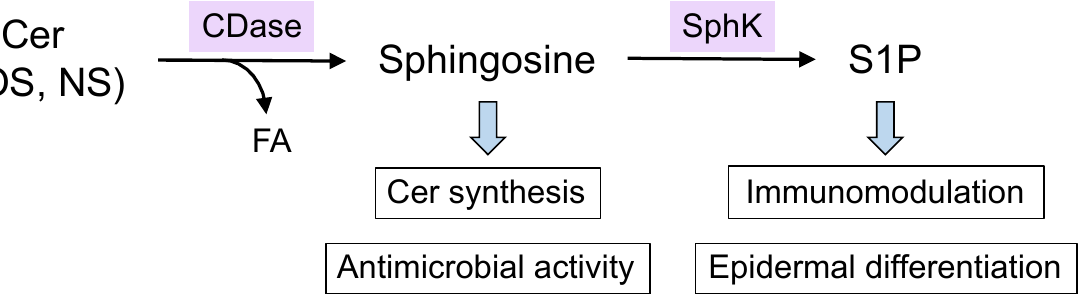
Figure 4. Degradation pathway of ceramides and function of ceramide metabolites. Sphingosine-containing ceramides, such as Cer[EOS] and Cer[NS], are degraded by ceramidase (CDase), which yields a fatty acid (FA) and sphingosine. The resulting sphingosine is metabolized to sphingosine-1-phospate (S1P) by sphingosine kinase (SphK). These ceramide metabolites have various physiological functions, as indicated in the boxes.